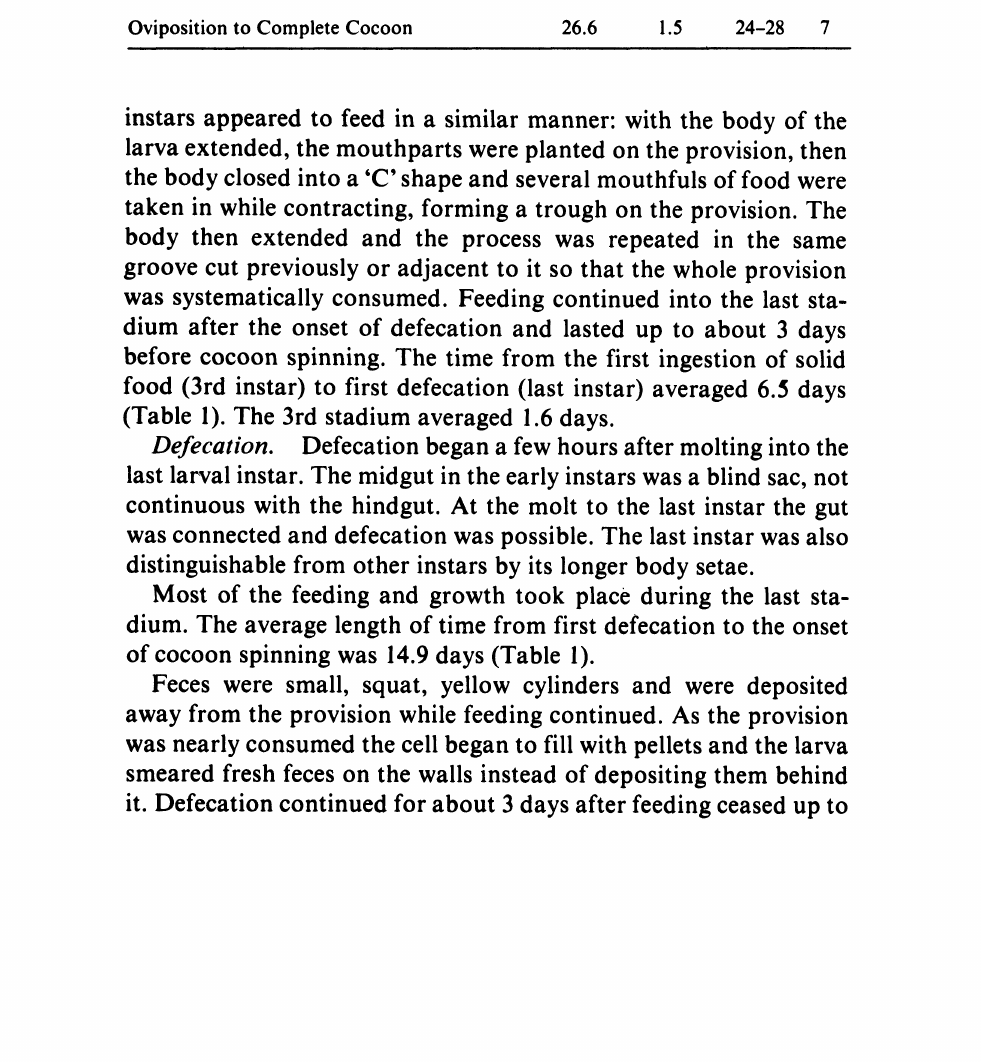
Table I. Life history and developmental times (days) for stages. Stage g sd range n Oviposition to Eclosion Eclosion to Solid Food Solid Food to First Defecation First Defecation to Cocoon Spinning Cocoon Spinning to Complete Cocoon Oviposition to Complete Cocoon